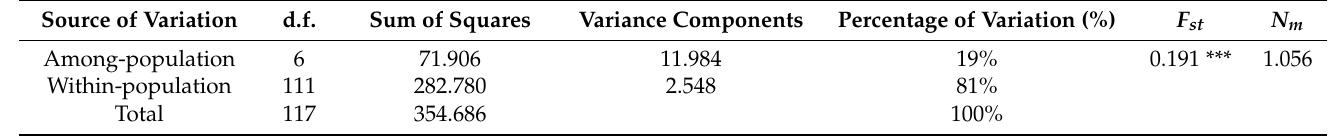
Table 2. AMOVA of genetic variation among seven populations of A. exitialis